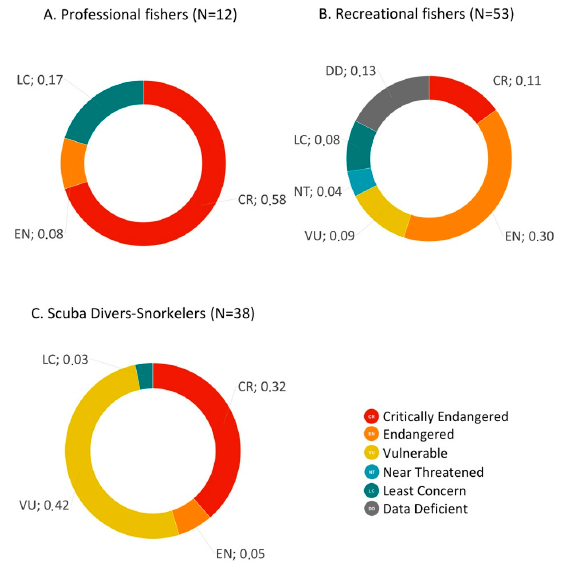
Figure 2. Percentage of observations per: ( A ) broader area as reported by citizen scientists to the MECO project (numbers represent the percentage of observations) and ( B , C ) types of observers (i.e., professional, recreational fishers, and scuba divers-snorkelers, respectively) in different conservation statuses. Critically Endangered (CR) = in a particular and extremely critical state; Endangered (EN) = very high risk of extinction in the wild; Vulnerable (VU) = meets one of the five red list criteria and thus considered to be at high risk of unnatural (human-caused) extinction without further human intervention; Near Threatened (NT) = close to being at high risk of extinction in the near future; Least Concern (LC) = unlikely to become extinct in the near future. Data Deficient (DD) = lack of sufficient data to evaluate the species status. Fishes 2021 , 6 , x FOR PEER REVIEW